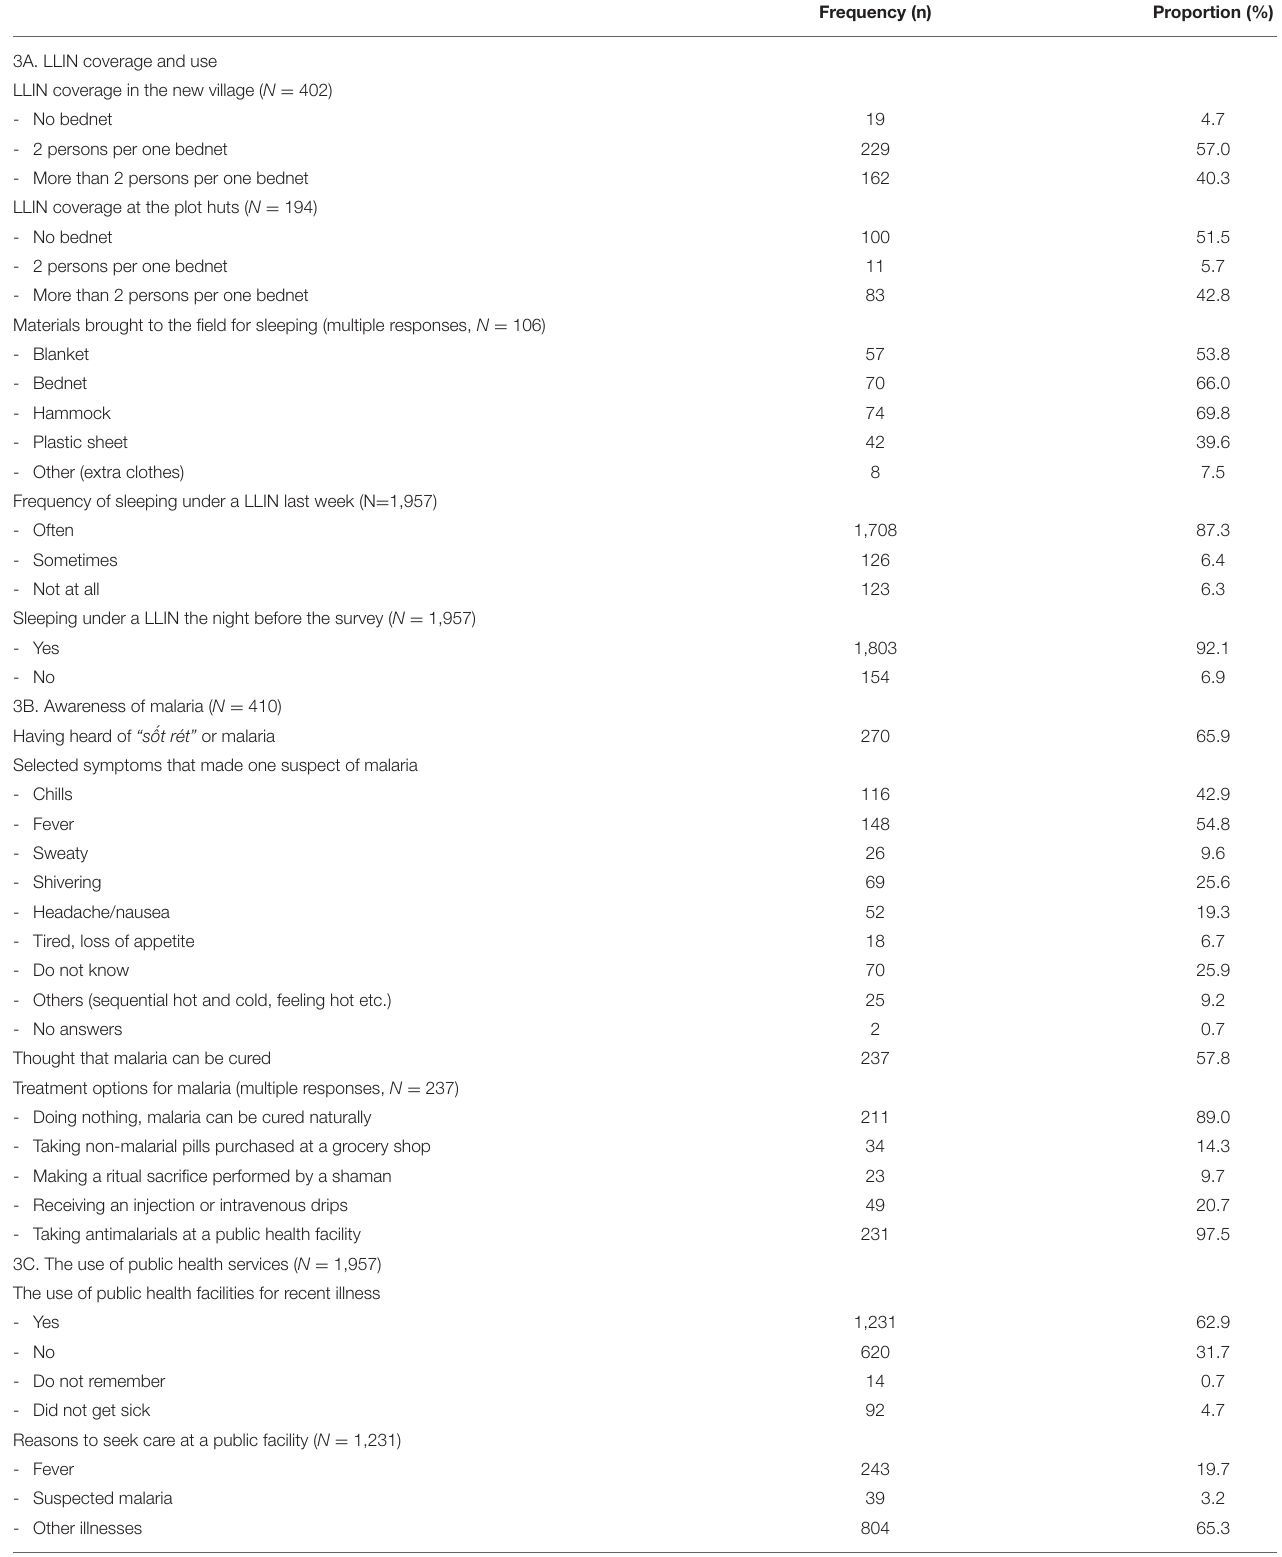
TABLE 3 | The uptake of public health